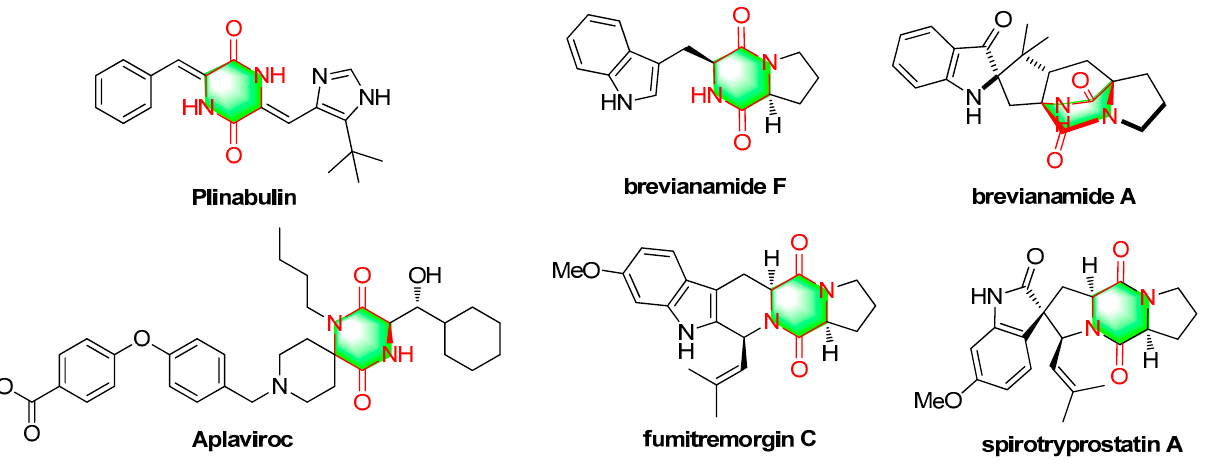
Figure 1. Natural products and pharmaceuticals containing DKP structures.